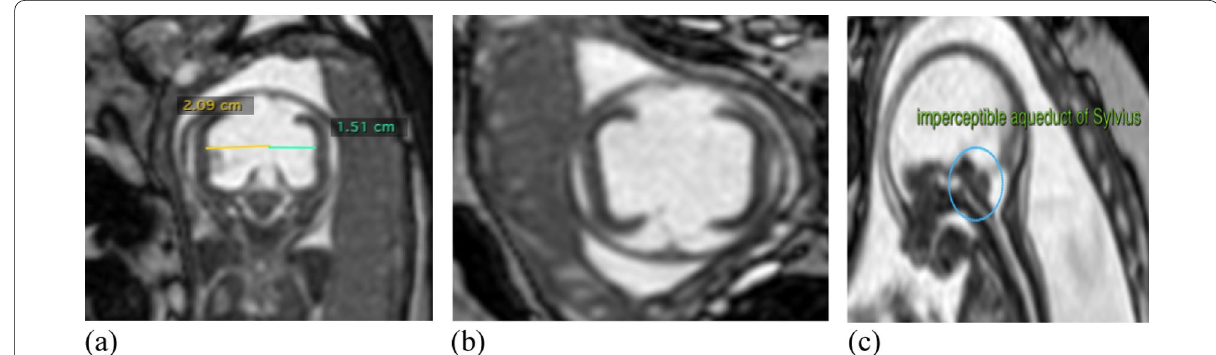
Fig. 2 Twenty-six-week fetus. SSFSE T2WIs in different planes; coronal, axial, and sagittal images a , b show asymmetric severe dilatation of lateral ventricle (right reaching 21 mm while the left reaching 15 mm in atrial width), secondary obliteration of the extra-axial spaces and thinning out of the cerebral parenchyma. There is a focal cortical destruction in both frontal and the left occipital lobes (spontaneous ventriculostomy). c The aqueduct of Sylvius cannot be visualized. Incomplete separation of both lateral ventricles because of interruption of septum pellucidum secondary to sever ventriculomegaly that could resemble mono-ventricle of holoprosencephaly; however, normal anterior and posterior cleavage of the cerebrum rules out the diagnosis of holoprosencephaly. MRI diagnosis: Severe supratentorial ventriculomegaly secondary to aqueduct stenosis. Recommendation: Termination of